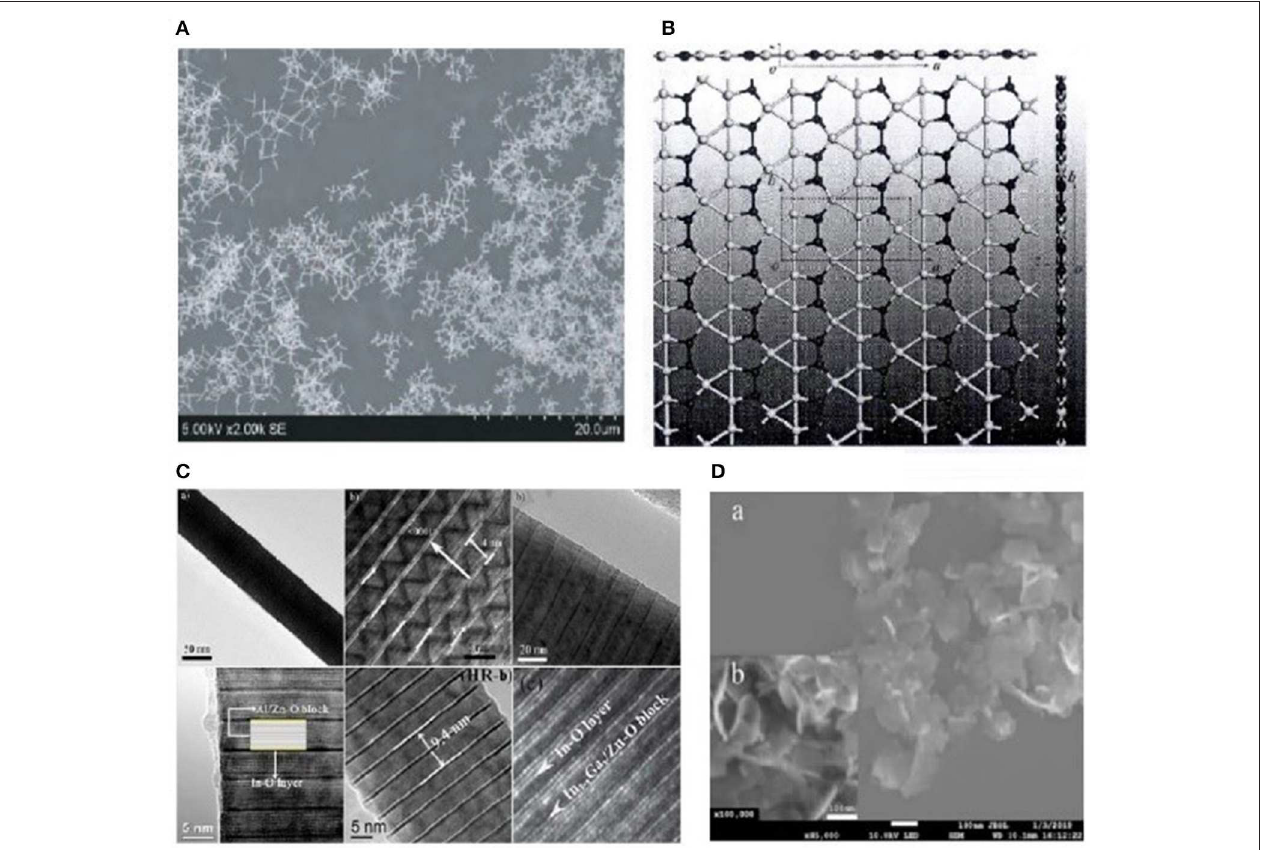
FIGURE 1 | Electron microscopic images of partial 2-D nanomaterials. (A) ZnO nanoscale membrane (adapted from Shen et al., 2018 with permission from Shen). (B) 2-D B 3 N 2 single-layer structure (adapted from Sun et al., 2016 with permission from Sun). (C) InMO 3 (ZnO) m superlattice (adapted from Wang, 2018 with permission from Wang). (D) New SnO 2 nanoscale sheets (adapted from Yue and Yu, 2019 with permission from